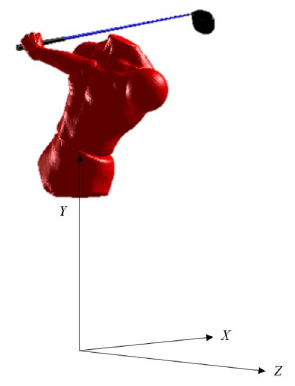
Figure 1. Four DoF golfer model at the initial condition of the